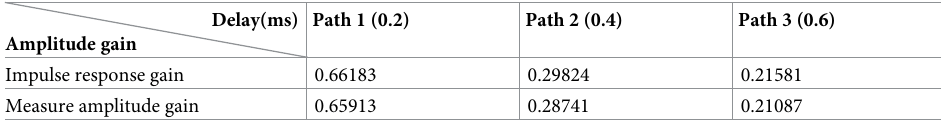
Table 1. Capture channel parameters of I and Q